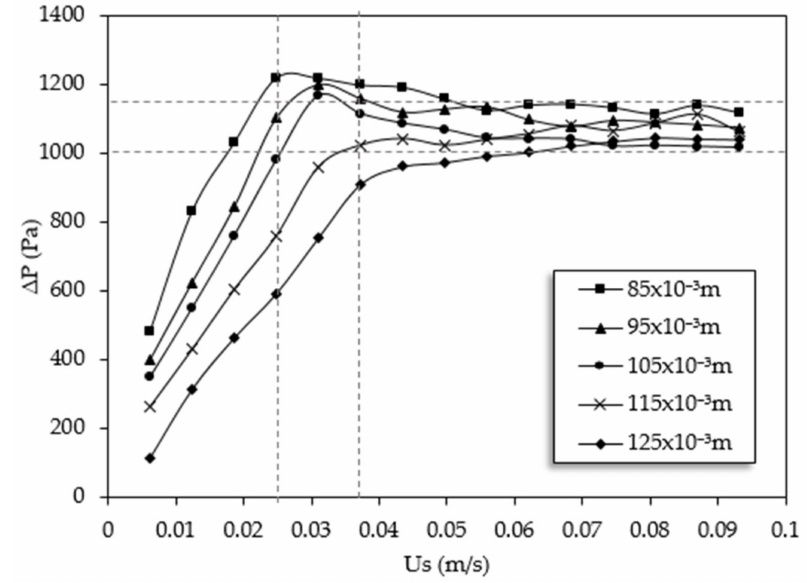
Figure 3. Minimum fluidization velocities as a function of bed heights of solid